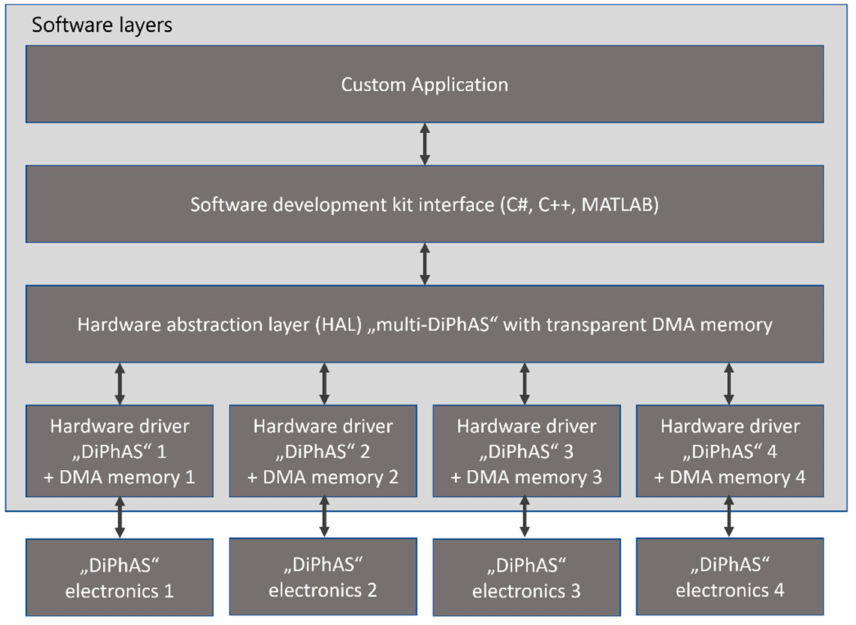
Figure 7. Software layers for user-transparent programming of four synchronized